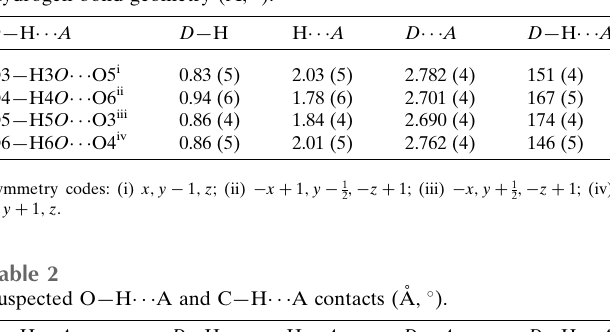
Table 1 Hydrogen-bond geometry (A˚ , (cid:3) ).